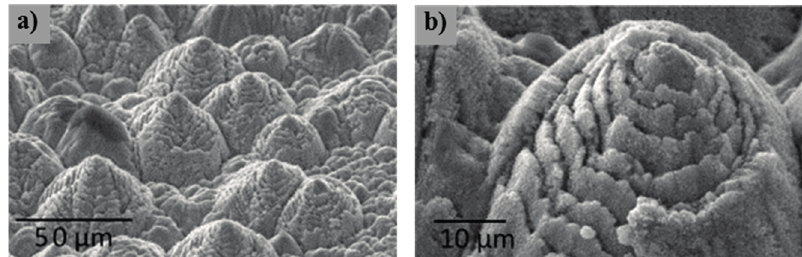
Figure 8. ( a ) NC pyramid on Ni, ( b ) magnified view showing the layered nanoparticle clusters